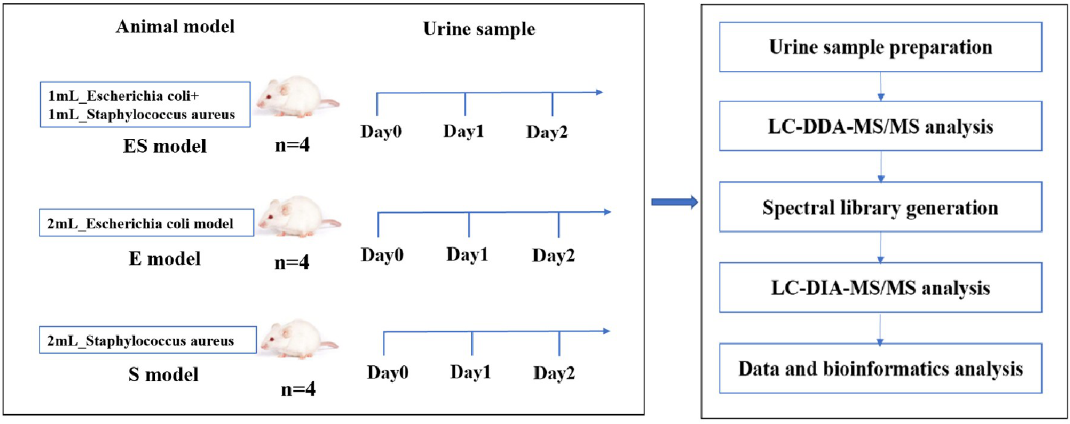
Fig 1. The workflow of this